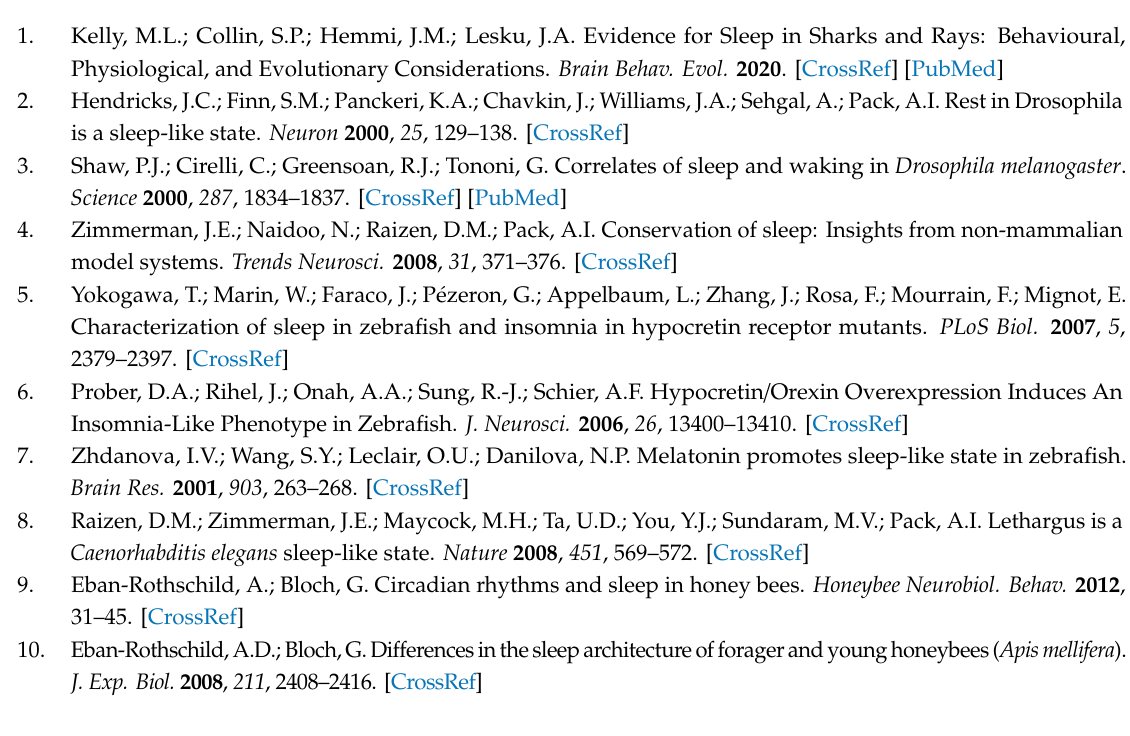
The representation and mapping of genes a ff ected (color marked) using ribosome pathway map (KEGG map:03010), Figure S2: The representation and mapping of genes a ff ected (color marked) using neuroactive ligand-receptor interaction pathway map (KEGG map:04080), Figure S3: The representation and mapping of genes a ff ected (color marked) using pathways in cancer map (KEGG map:05200), Figure S4: The representation and mapping of genes a ff ected (color marked) using glycerophospholipid metabolism pathway map (KEGG map:00564), Table S1: List of real time PCR gene primers / probes used in microarray validation experiments, Table S2: List of genes upregulated in brain (A), downregulated in brain (B), upregulated in liver (C), downregulated in liver (D), Table S3: List of common genes a ff ected in brain and liver, Table S4: Log fold change of gene expression after REM sleep loss compared to control, Table S5: List of GO terms related to synaptic plasticity, Table S6: List of GO terms related to immune